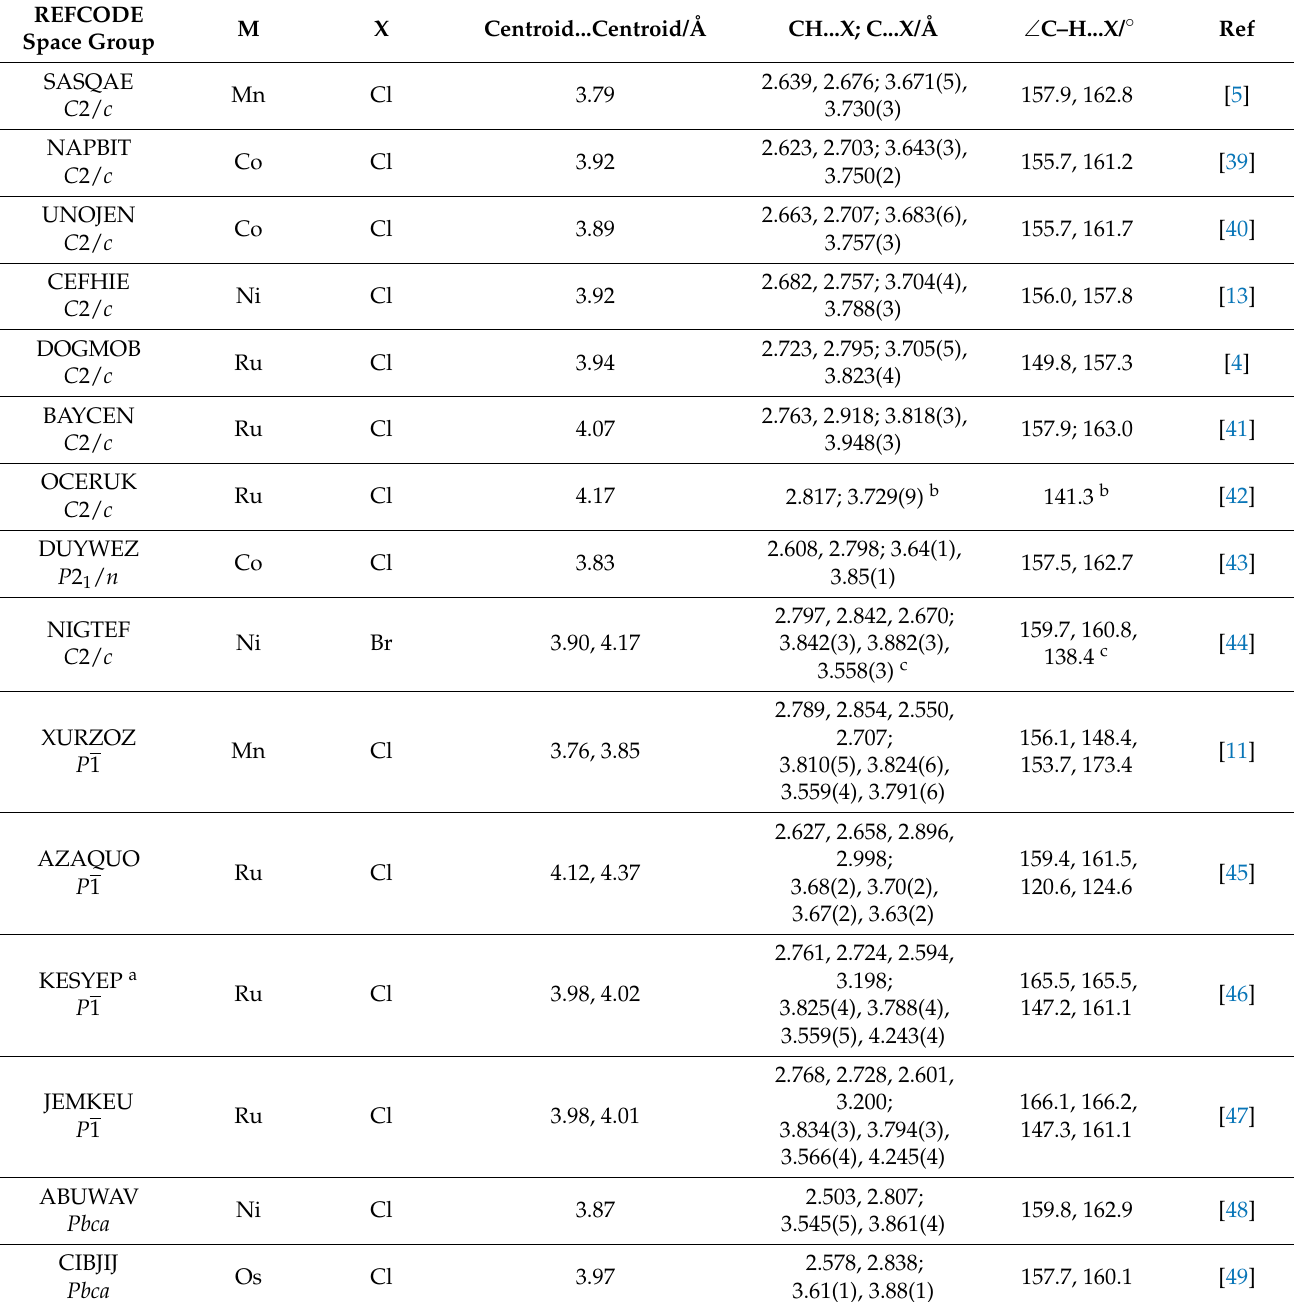
Metric parameters for the bpy...bpy π -stacking and CH bpy ...X interactions in